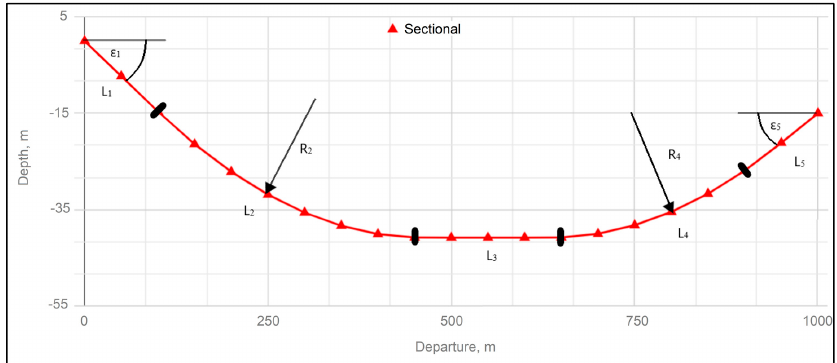
Figure 9. Trajectory being a combination of straight and curvilinear sections.